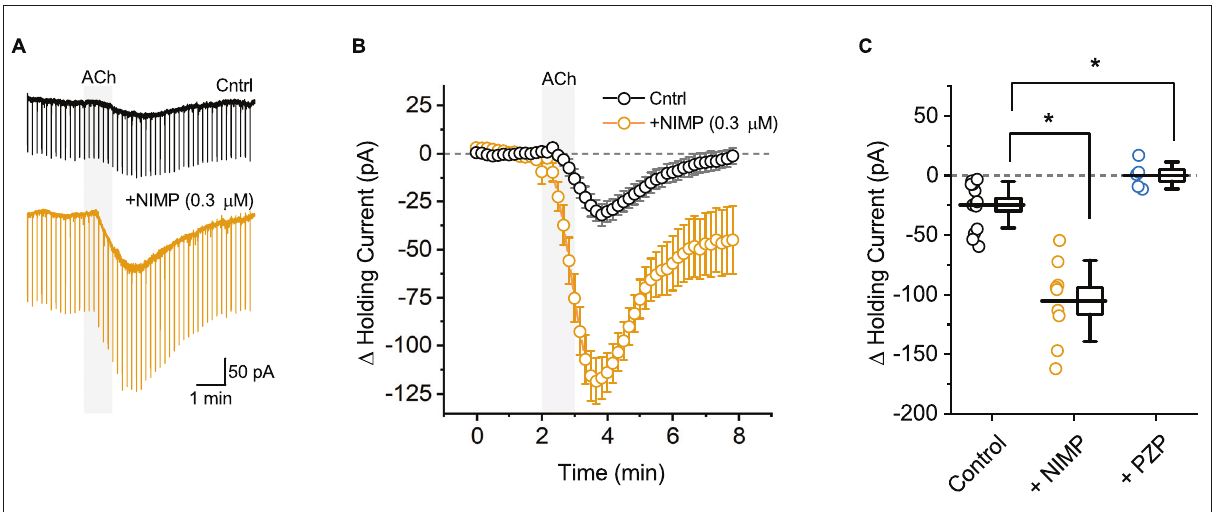
FIGURE1 ACh-induced changes in holding current in BLA pyramidal neurons can be used to quantify the effects of central AChE inhibition. (A) Representative holding current traces from BLA pyramidal neurons illustrating the response to acute bath application of 100 µ M ACh (shaded region) in control conditions (black) and following exposure to NIMP (0.3 µ M, orange). Rapid transients observed in these traces were produced by a membrane test delivered every 10 s (see “Materials and methods” Section). (B) ACh-induced change in holding current over time as recorded in neurons from control slices ( n = 14, open black circles) and in neurons from slices preincubated in 0.3 µ M NIMP (open orange circles, n = 9). ACh was bath applied from 2 to 3 min (gray shaded area). Error bars represent the SEM. (C) Summary data illustrating the ACh-induced change in holding current, observed from 3 to 4 min as plotted in panel (B) , for each cell in the control and NIMP datasets (open black and orange circles respectively). Blue circles illustrate the effect of ACh on holding current in neurons from control slices, as observed in the presence of 1 µ M PZP. For each group, box height illustrates the SEM, whiskers illustrate the SD, and horizontal lines highlight the group means. Asterisks indicate p < 0.05.